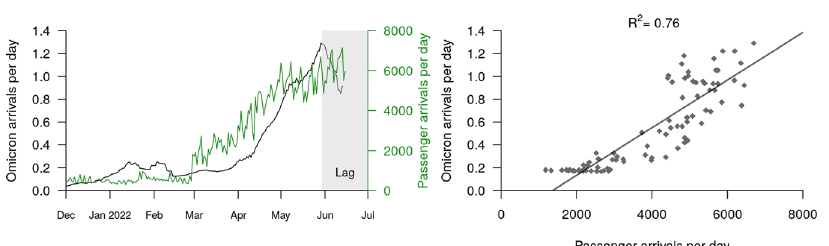
Fig. 6 | Estimated rate of Omicron arrival into the community. Left: Estimated Omicron arrivals (into the community) and recorded passenger arrivals (into the country). The black curve is equal to a smoothed sum of the fi ve black curves in Fig. 5. The Omicron arrival rate appears to drop off at the start of June, but this is simplyduetoalagbetweenlineagesarrivingattheborderandthenbeingdetected